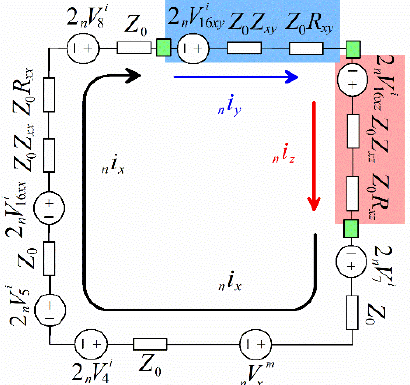
Figure 5. Thevenin equivalent circuit of the series node for H x at time t n . Green boxes denote a formal connection, allowing for the current to be n i x at the link lines, the source, and lines 16 xx and 22 xx , while the current is n i y for lines16 xy and 22 xy (in the pale blue region) and n i z for lines16 xz and 22 xz (in the pale red region).